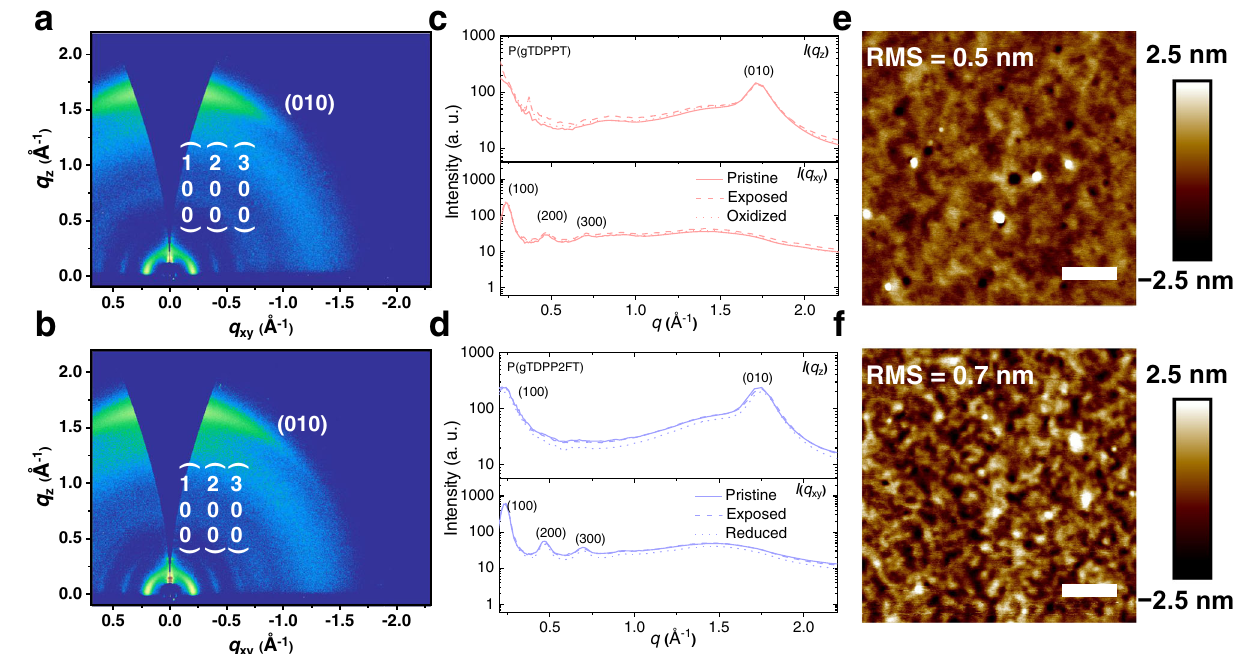
Fig. 4 | Molecular packing and morphology characterization. a , b 2D-GIWAXS patterns of P(gTDPPT) and P(gTDPP2FT). c , d The corresponding line cuts of the P(gTDPPT) and P(gTDPP2FT) GIWAXS pattern. Cuts along the q xy direction repre- sent scattering in the in-plane direction, while the q z is from the out-of-plane direction. “ Pristine ” stands for dry fi lms without any treatment. “ Exposed ” stands